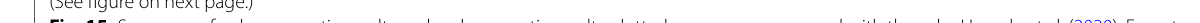
(See figure on next page.) Fig. 15 Summary of paleomagnetic results and rock magnetic results plotted versus age compared with those by Haneda et al. (2020). From top to bottom, a S ratio ( S and S shown by solid circles and solid triangles, respectively), b k ARM / k LF , c k LF (solid circles) and k ARM (solid triangles), − 0.1 T − 0.3 T d relative paleointensity (NRM 30–50 /ARM 30–50 ), and e VGP latitude. Details on measurements and calculations of relative paleointensity is explained in the text. Black symbols indicate the results for the 1st sampling and the blue ones those for the 2nd sampling (Block G in Additional file 3: Figure S3(c) and Additional file 4: Figure S4(e)). Large and small symbols (black and blue circles) correspond to the highest (3) and second highest (2) reliabilities (Additional file 7: Table S2), respectively. Purple open circles are paleomagnetic results from Haneda et al. (2020) and small symbols are paleomagnetic data with MAD > 15°. Vertical dashed line is the M–B boundary. Vertical pink lines are tephra layers, which correspond to tephra A, Byk-E tephra, and tephra C from younger to older ages, respectively. Age model for this study is primarily based on the age of Byk-E tephra (774.1 ka; Suganuma et al. 2018) as a fixed point and correlation of relative paleointensity variations with those from Haneda et al. (2020). The best correlation is obtained by assuming sedimentation rates of 30 cm/kyr and 18 cm/kyr for the intervals above and below Byk-E tephra layer,